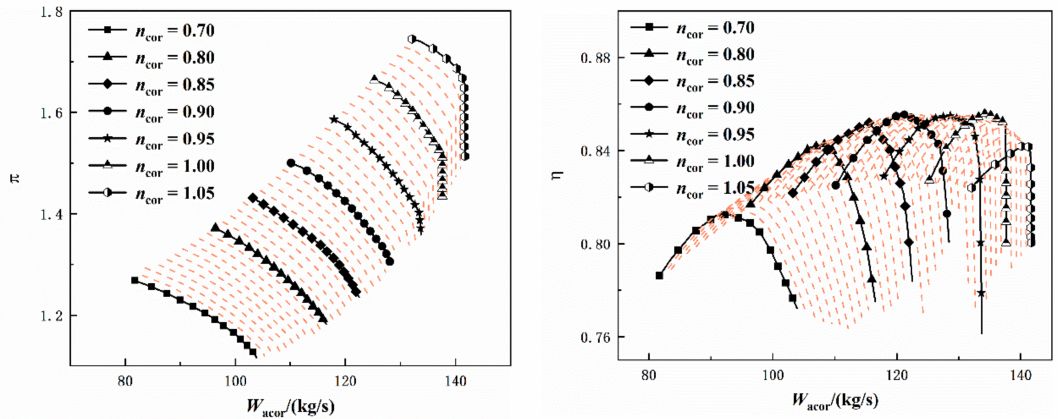
Figure 6. Extended characteristic maps based on two-dimensional interpolation.